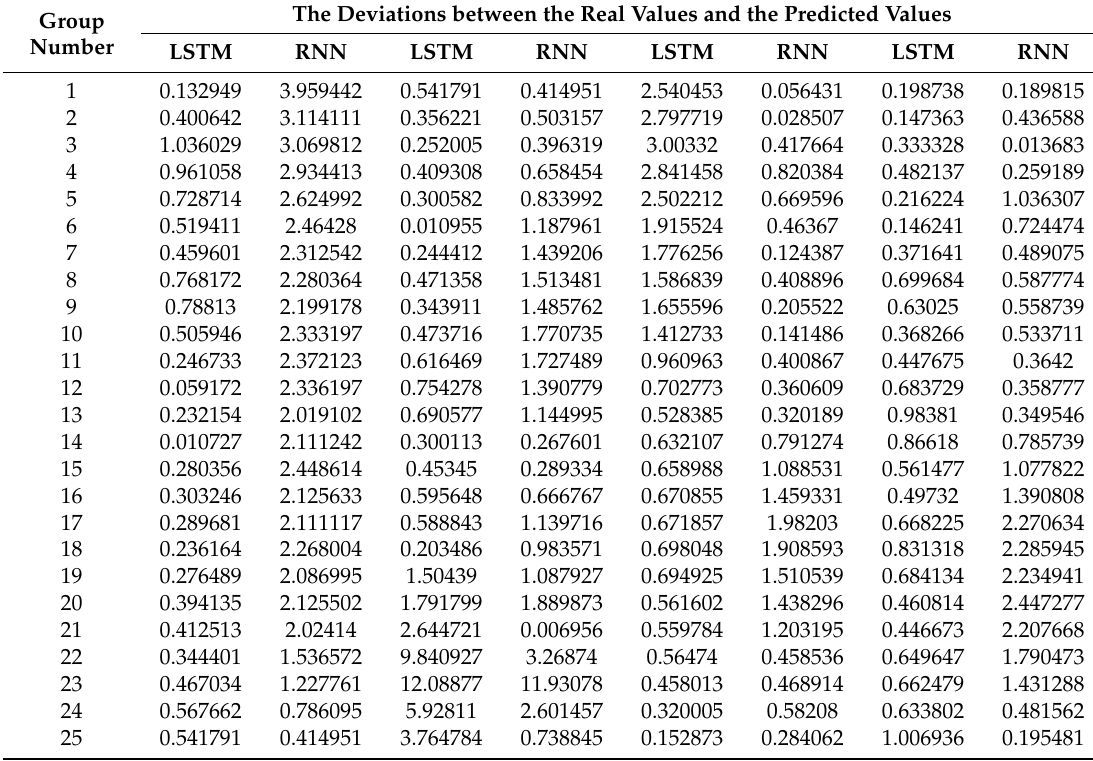
Table 4. Deviations between the predicted values and the real values using RNN and